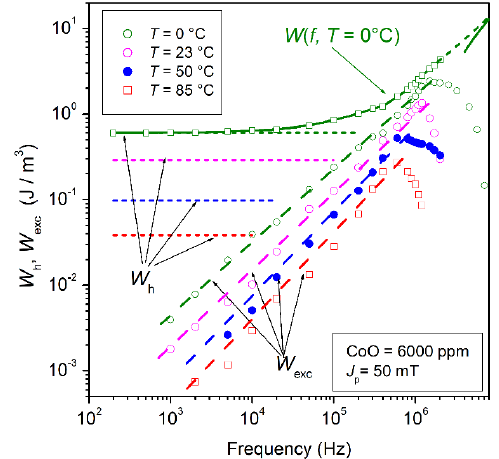
Figure 16. Hysteresis W h and excess W exc,sd ( f ) loss components versus temperature ( J p = 50 mT, T = 0, 23, 50, 85 °C) in a 6000 ppm CoO-doped Mn-Zn ferrite. The decrease in the effective anisotropy with increasing T justifies the associated decrease in the dw-related loss contributions. The correlation between the W h and W exc,sd ( f ) dependences on T confirms that both quasi-static and dynamic dw displacements respond the same way to strength and distribution of the pinning fields. (Partly adapted from Ref. [42]).